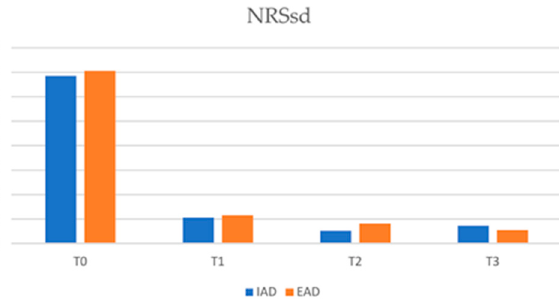
Figure 4. Numerical rating scale sleep disturbance (NRSsd) in IAD and EAD patients (IAD = intrinsic atopic dermatitis; EAD = extrinsic atopic dermatitis).